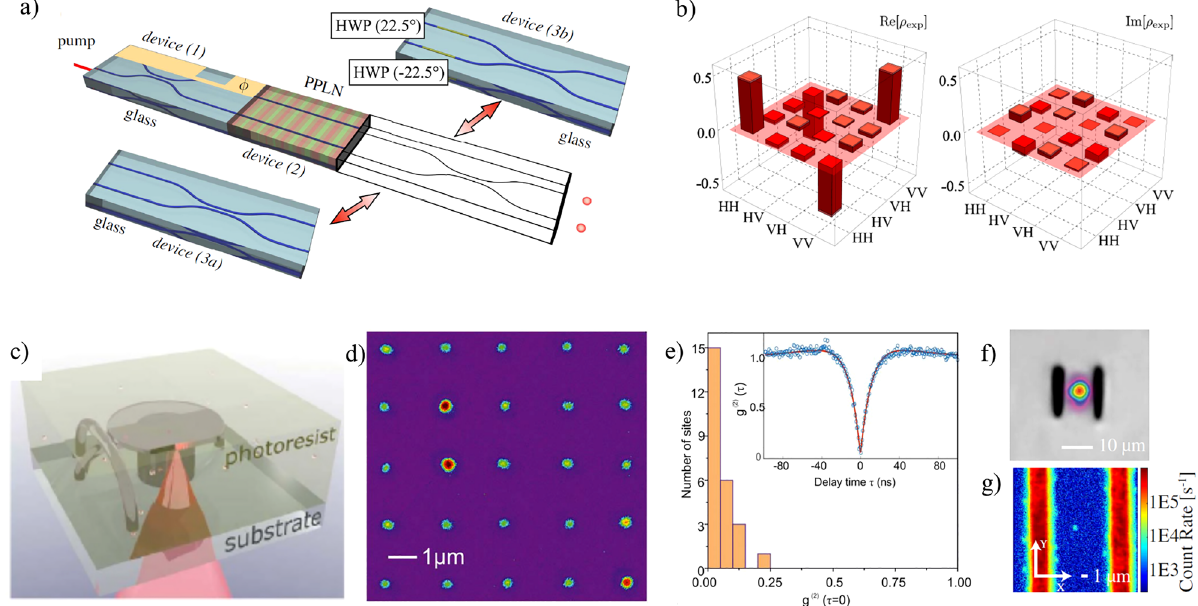
Figure 3: (a) Schematic of the integrated single photon source presented in [ 45 ]. A first reconfigurable glass chip is used for pump splitting. The PPLN chip is used for photon pairs generation. The third stage can be interchanged between device 3a and 3b in order to engineer different types of biphoton states. (b) Results of the quantum state tomography performed on the state produced by the device presented in [ 45 ], when set to generate the polarization-entangled | 𝜙 − ⟩ state. Reported fidelity with the theoretical state is 93%. (c) Schematic of the 2-photon polymerization process employed in [ 34 ] for fabricating integrated nanophotonic devices with embedded nanodiamonds. (d) Fluorescence map obtained from a 5 × 5 square lattice of nitrogen vacancy (NV) centers fabricated by FLM in [ 77 ]. Lattice parameter is 2 μ m. (e) Histogram showing the second order autocorrelation results obtained for the fluorescence light of all NV centers shown in panel (d). In the inset, a whole g (2) ( t ) trace measured for a single defect is shown. (f) Transverse cross section and near field image of the guided mode of the type II waveguide fabricated in diamond and presented in [ 78 ]. (g) Photoluminescence image of the longitudinal profile of the same waveguide as in panel (f), where it can be clearly noticed the presence of an individual NV center localized within the core. The panels of this figure contain pictures adapted from Refs. [ 34 , 45 , 77 , 78